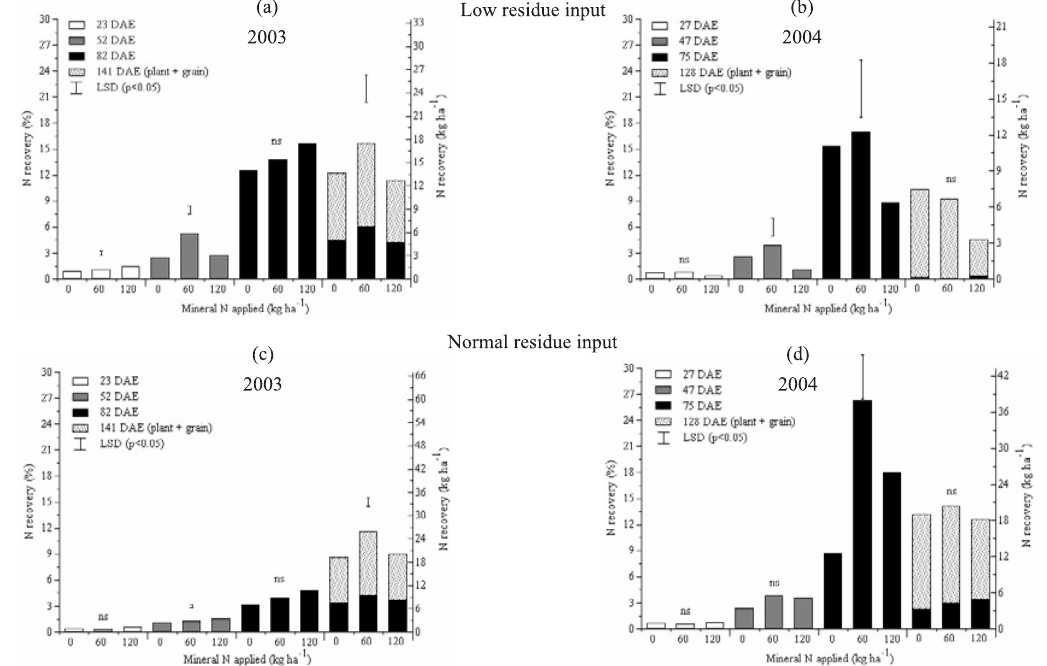
Figure 2. 15 N recovery by maize plants, absolute and relative to the amount of 15 N in the labeled hairy vetch residues at different maize stages as a function of low residue (a, b) and normal residue input levels (c, d) in 2003 and 2004. DAE= days after maize emergence. Vertical bars are the minimum significant difference by Duncan’s test (p ≤≤≤≤≤ 0.05). ns = not